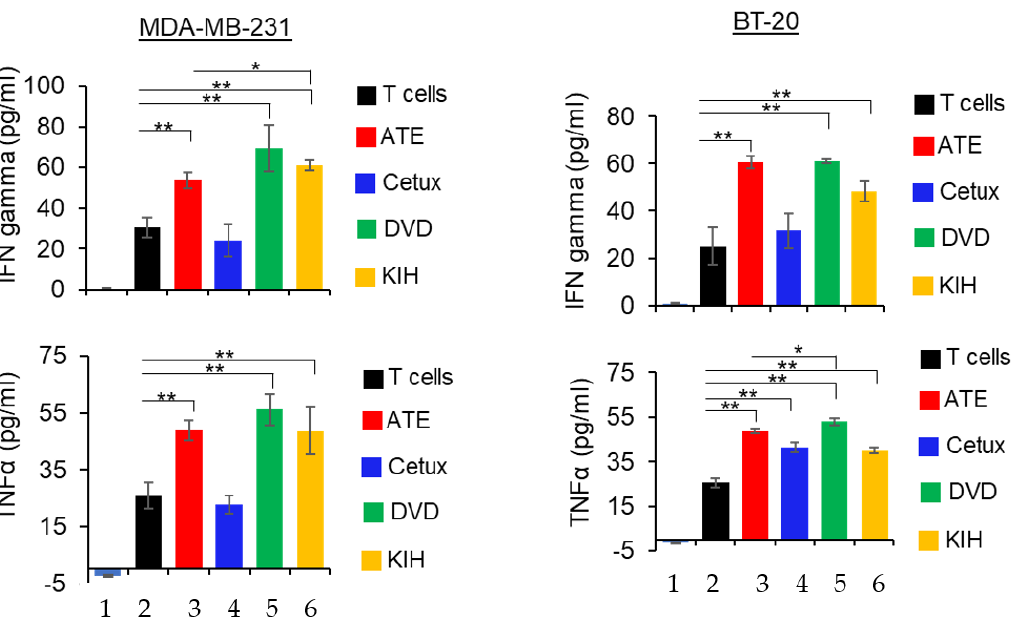
Figure 6. Detection of IFNγ and TNFα in co-culture of cancer cells and T cells in presence of parental mAbs and BsAbs. After 24 h of incubation, the supernatant was collected and then subjected to ELISA assay kit (R and D systems) to detect IFNγ and TNFα. Bar# 1 of each bar graph represents tumor cells only. Bar# 2,3,4,5,6 of each bar graph represents tumor cells co-cultured with T cells. Bar# 3,4,5,6 represents antibody treatments indicated in color codes. This experiment has been performed in biological triplicates, and data are representative of two or more independent experiments. The differences between two groups were considered statistically significant when p < 0.05 (*, p < 0.05; **, p < 0.01).